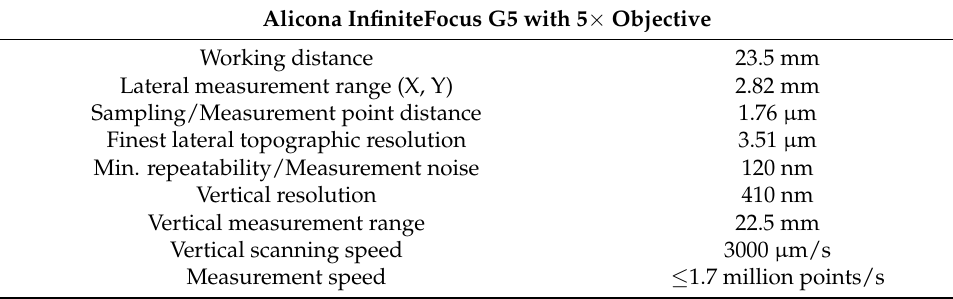
Figure 6. The 3D scanning microscope during the measurement of a particular concrete specimen. Table 2. Specifications of the deployed 3D scanning microscope system.